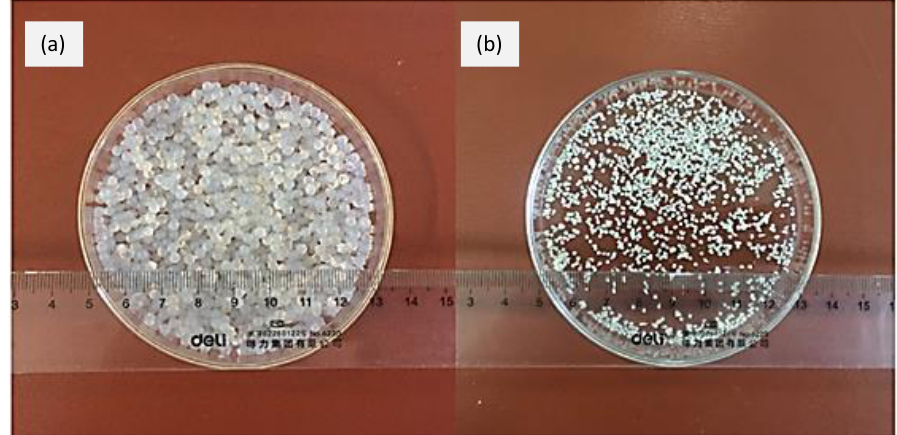
Figure 8. 5-FU-loaded Alg/Cs/kC microbeads, and digital photographs of freshly prepared ( a ) wet and ( b ) dry microbeads [91], reproduced with permission from Elsevier.